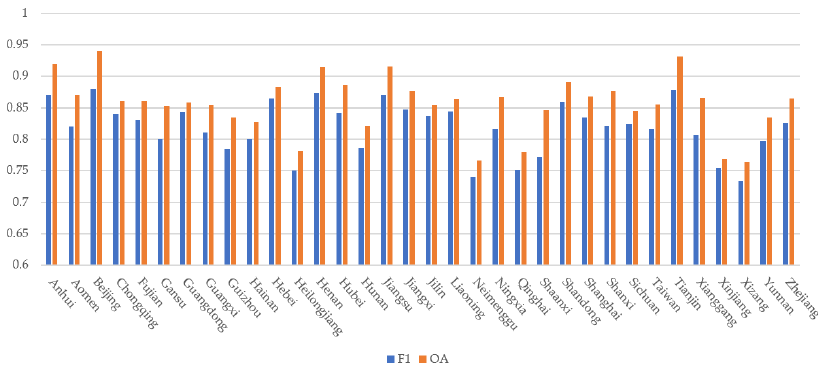
Figure 14. The accuracy evaluation for each province or region of China.